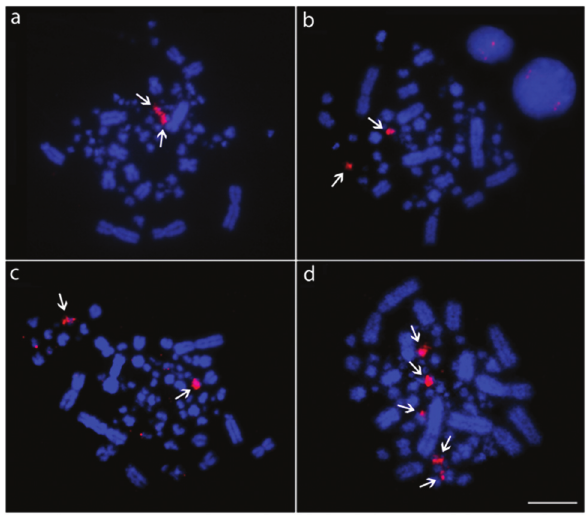
Figure 3 - Representative examples of FISH experiments using 18S rDNA probes in Columbidae species. (a) L . verreauxi ; (b) Z . auriculata ; (c) C . livia ; (d) C . picui . The arrows point to the hybridization signals. Bar = 5 (cid:2) m.